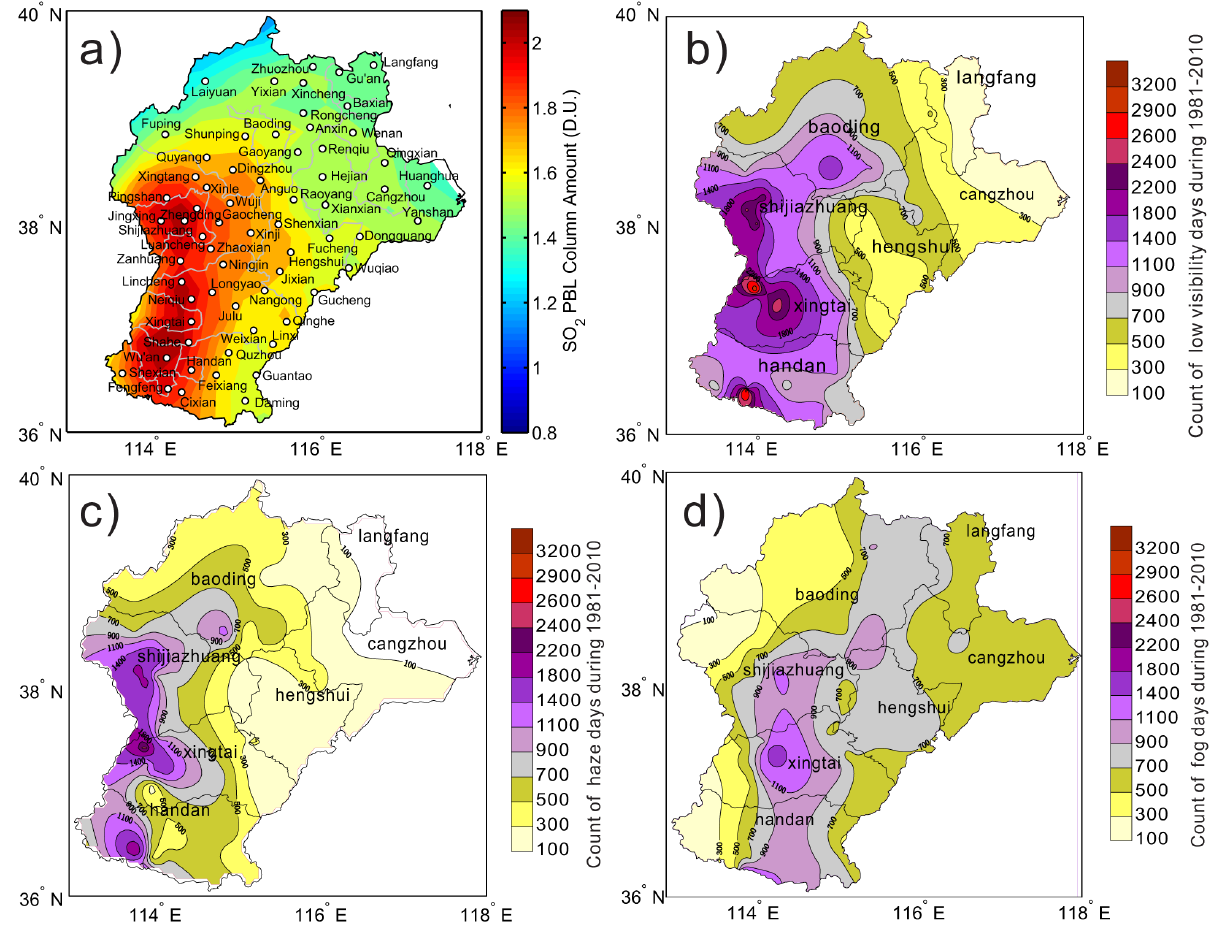
Figure 2. (a) Average OMI SO2 PBL column amount during the period 2005–2012 with the location of the 64 stations and the number of (b) low visibility, (c) haze and (d) fog days during the period 1981–2010 in the southern